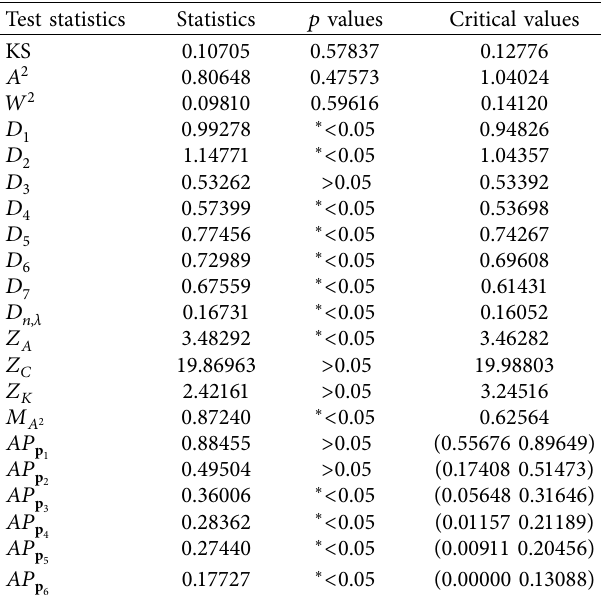
Table 6: Test statistic and corresponding p values from simulated